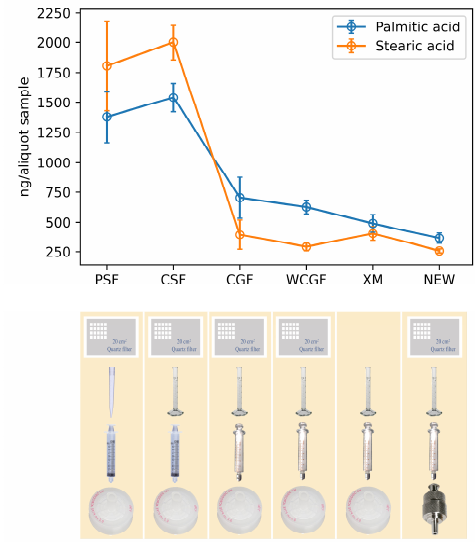
Figure 4. Contamination levels for palmitic acid and stearic acid in ng / aliquot sample (20 cm 2 ), with error bars in ± SD obtained from three repeat experiments. The abbreviations for different combinations of plastic / glass labware used in investigation are (1) PSF representing pipette, syringe and filter cassette (all plastic) used in the original method; (2) CSF representing a glass measuring cylinder, plastic syringe, and plastic filter cassette combination; (3) CGF representing a glass measuring cylinder and a glass syringe and plastic filter cassette combination; (4) WCGF: wash the CGF filtration set with 2 mL methanol 3 times; (5) XM: CGF combination but without aerosol filter matrix; and (6) NEW: revised method in which a glass measuring cylinder, a glass syringe and a stainless-steel syringe holder were used.